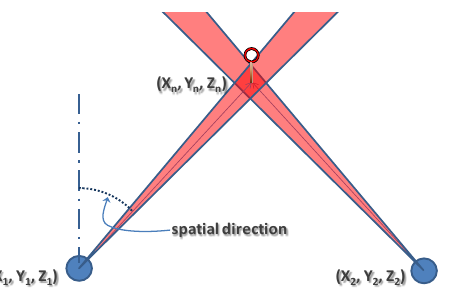
Figure 1. Schematic representation of point measurement using forward intersection